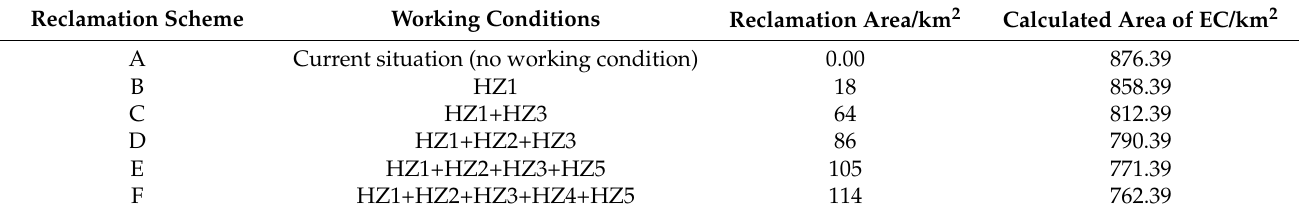
Table 11. Changes in marine area of Haizhou Bay (scenario